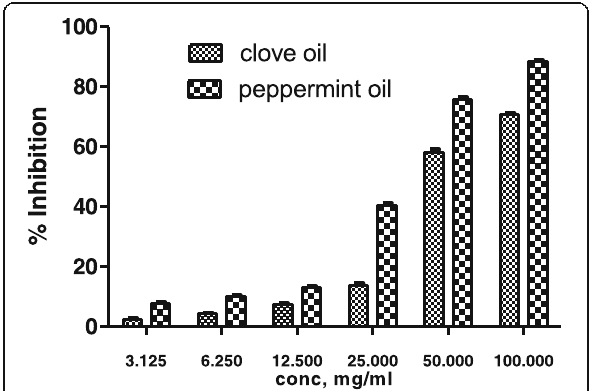
Fig. 2 Gtf inhibitory effects of clove and peppermint oils at various concentrations